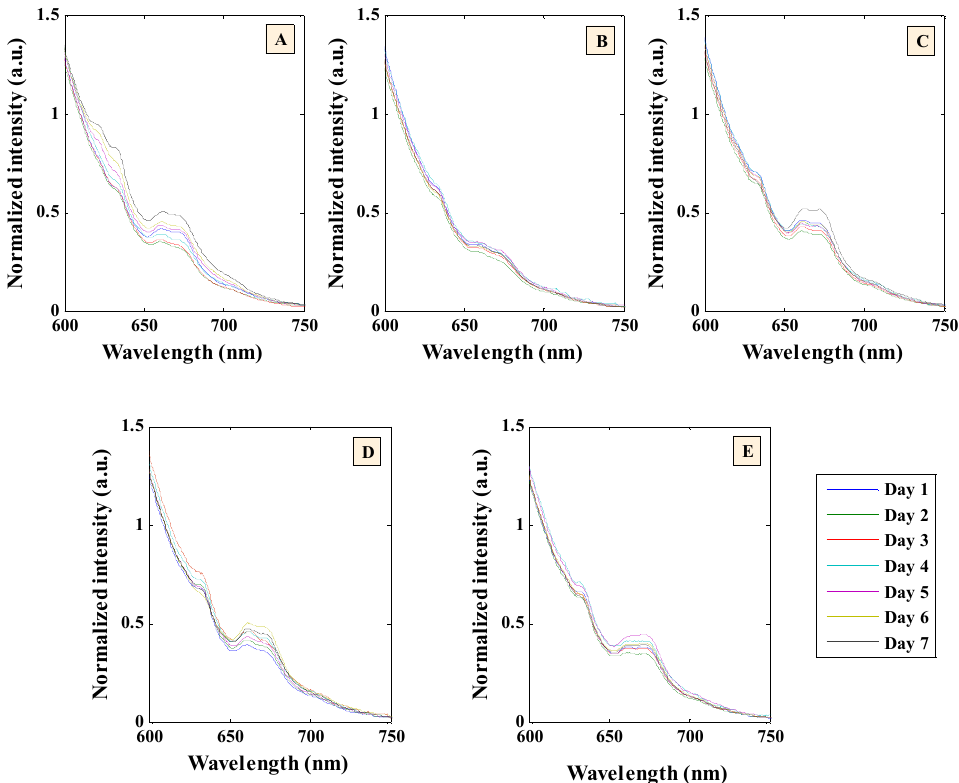
Figure 3. Normalized fluorescence spectra of each kind of yogurt during the measurements over one week.